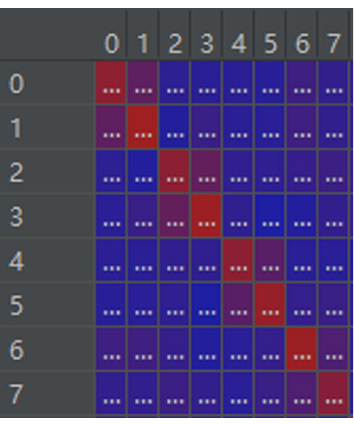
Fig. 3 H T M H M in multi-antenna user equipment (MAUE) with ξ r = 0, ξ t = 0.2, m UE = 2